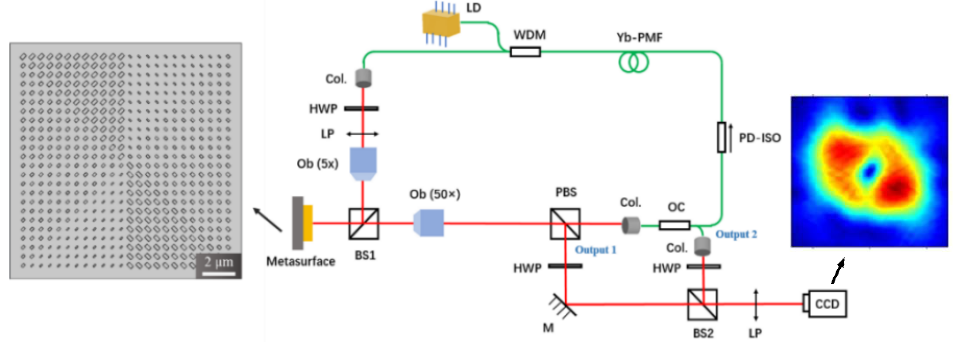
Figure 21. Schematic of the metasurface-assisted structured light fibre laser (Adapted from an open-access source Ref. [124]).